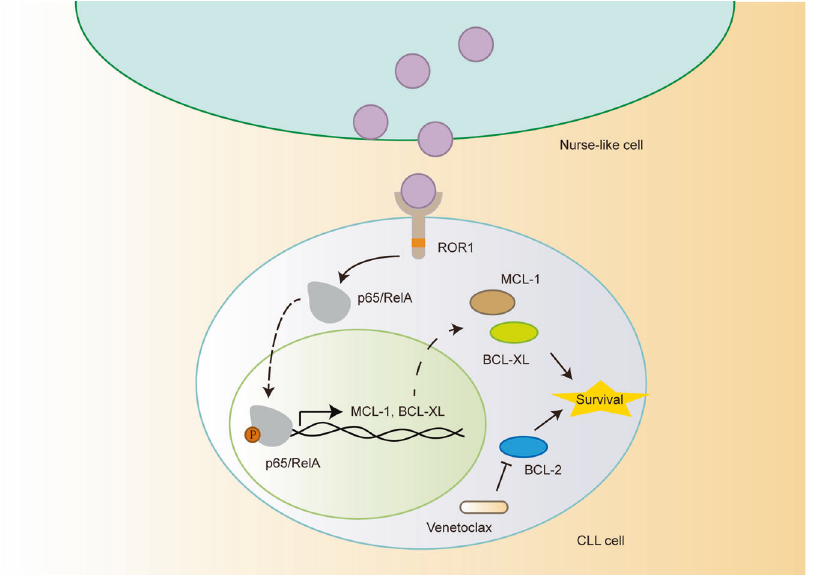
Fig. 7 The model for resistance to venetoclax in CLL cells. NLCs-Wnt5a-induced activation of NF- κ B drives resistance to venetoclax in CLL cells through upregulation of MCL1 and BCL-XL. Cell Death Discovery (2022)